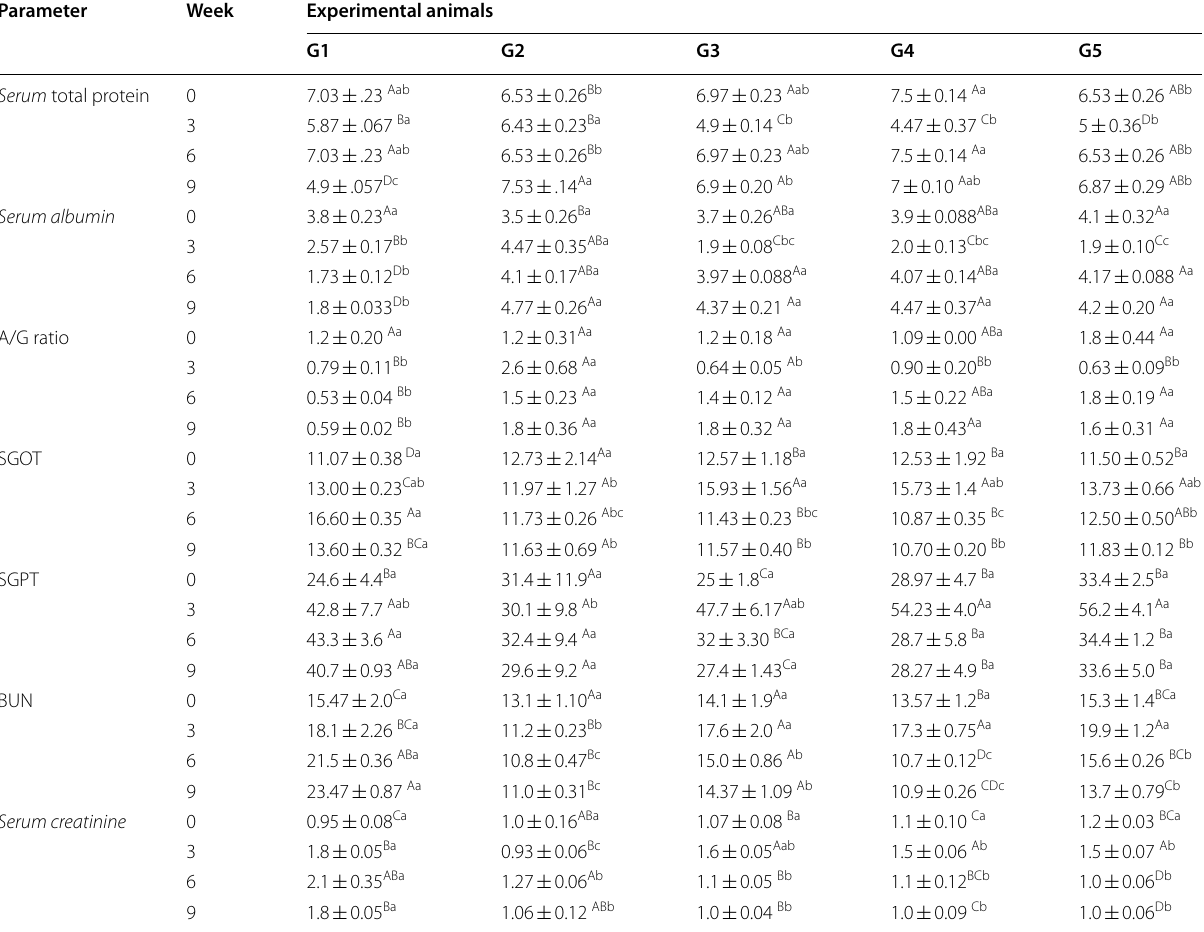
G, lambs group Capital letters: means within the same column of different letters are significantly different at ( P < 0.01). Small letters: means within the same row of different letters are significantly different at ( P <